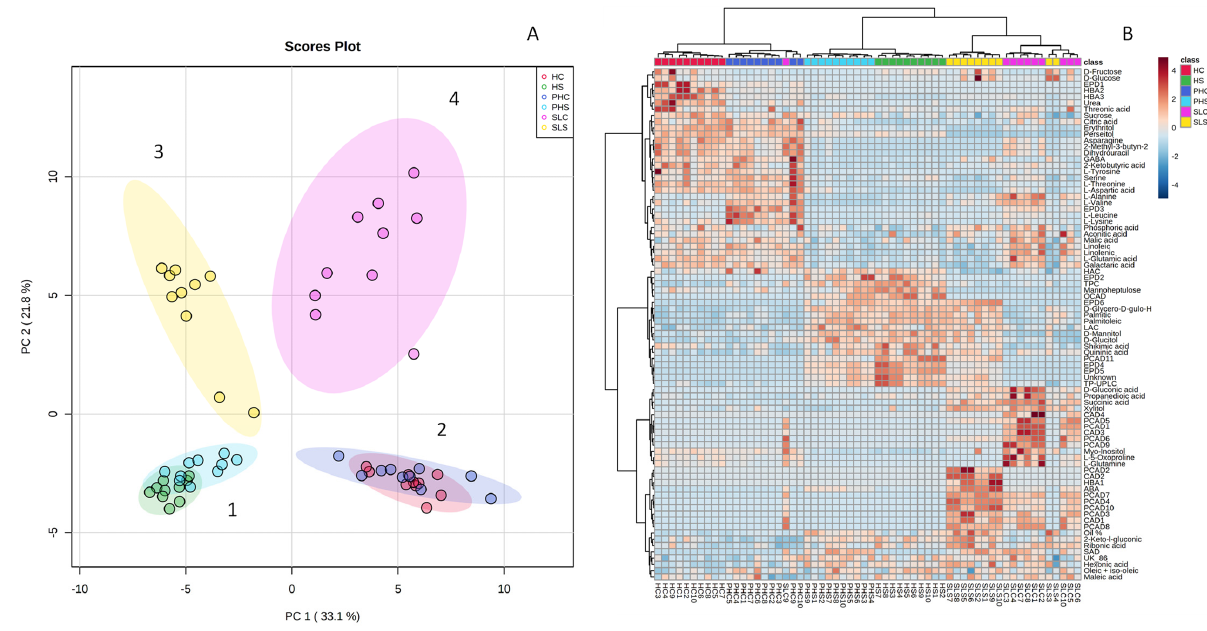
Figure 7. ( A ) Principal component analysis (PCA). ( A ) Score plot based on all primary and secondary metabolites measured of Hass avocado fruit representing a short (Spain) and long-distance supply chain (Chile): from harvest (HC and HS; for Chile and Spain), after the simulated transport chain (PHC and PHS; for Chile and Spain), and at the ready-to-eat stage (SLC and SLS for Chile and Spain). ( B ) Heat map based on cluster analysis using the Euclidean distance and Ward algorithm. Numbers 1-4 correspond to different clusters formed.